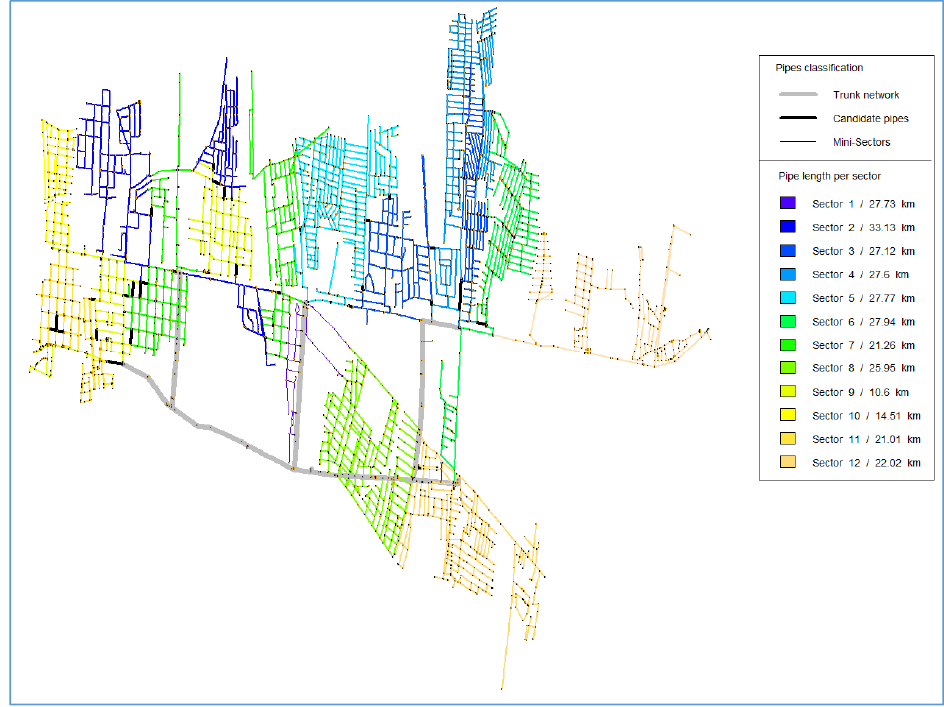
Figure 6. Final partition including the set of candidate pipes.